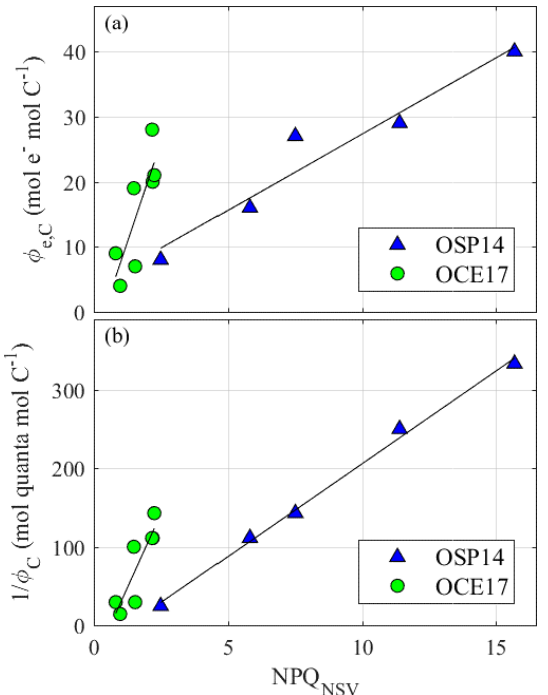
Figure 8. (a) Correlations between the electron requirement of car- bon fixation, (cid:56) e , C and NPQ NSV , both derived for in situ light in- tensity at the time and depth of sampling for each time point during daylight hours. OCE17: (cid:56) e , C = 12 . 2 · NPQ NSV − 4 . 53; R 2 = 0 . 68; n = 7. OSP14: (cid:56) e , C = 2 . 34 · NPQ NSV + 3 . 74; R 2 = 0 . 94, n = 5. (b) Correlations between the photon requirement of carbon fixa- tion, 1 /(cid:56) C and NPQ NSV , both derived for in situ light intensity at the time and depth of sampling for each time point during day- light hours. OCE17: 1 /(cid:56) C = 75 · NPQ NSV − 46; R 2 = 0 . 68; n = 7. OSP14: 1 /(cid:56) C = 23 · NPQ NSV + 30; R 2 = 0 . 94; n =